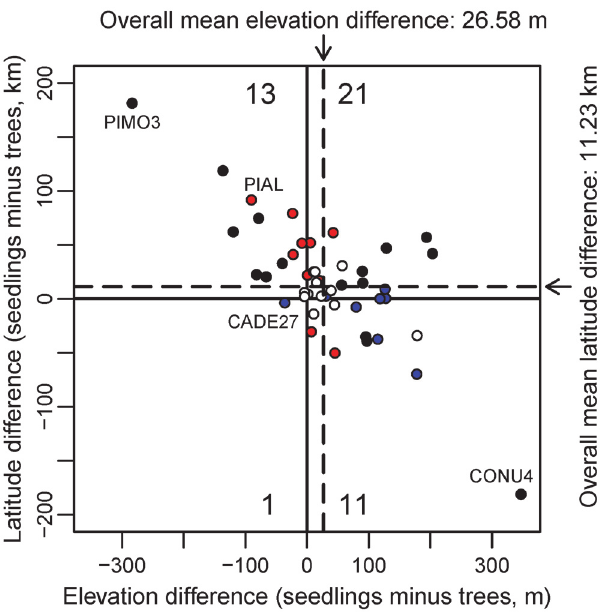
Fig 3. Latitudinal and elevational range shifts. A positive number indicates that the mean of the seedling range is higher than or to the north of that of trees. Dashed lines represent the overall mean difference across all species. White circles represent species for which neither the difference in elevation or latitude is significantly different from 0 at the 0.05 level; red circles represent species for which the difference in latitude is different from 0, but not that of elevation; blue circles represent species for which the difference in elevation is different from 0, but not that of latitude; black circles represent species for which the difference in both latitude and elevation is different from 0. The numbers in each quadrant represent the number of species in that quadrant. Species mentioned in the text are labeled: Pinus monticola (PIMO3), Pinus albicaulis (PIAL), Calocedrus decurrens (CADE27), Cornus nuttallii